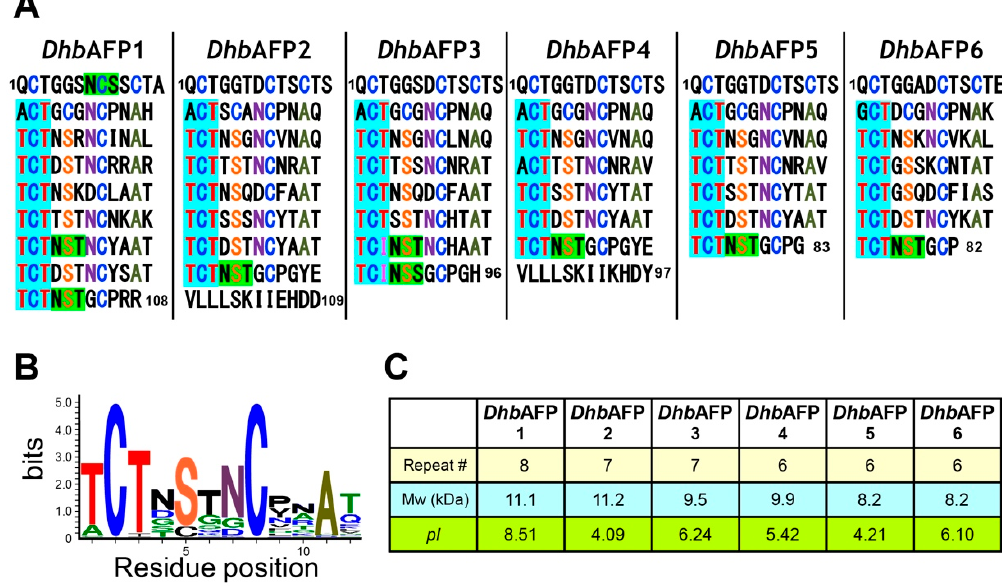
Figure 2. Amino acid sequence of Dorcus hopei binodulosus ( Dhb) AFP. ( A ) Sequence comparison between the six Dhb AFP isoforms. Each consists of 6–8 tandem repeats of a 12-residue consensus sequence, in which “TCT” locating the 3 ranks of ice-like waters are highlighted with cyan. N-glycosylation sites (NxT/S, x is any residue) are highlighted with green. ( B ) The WEBLOGO plot (http://weblogo.berkeley.edu/ (accessed on 5 May 2020)) showing the consensus amino acid sequence based on the alignment of all Dhb AFP sequences. The 12-residue consensus sequence TCTxSxNCxxAx was deduced from this plot. ( C ) Biochemical properties of the six Dhb AFP isoforms. Number of tandem repeats, estimated molecular weights, and isoelectric points were evaluated for each isoform.